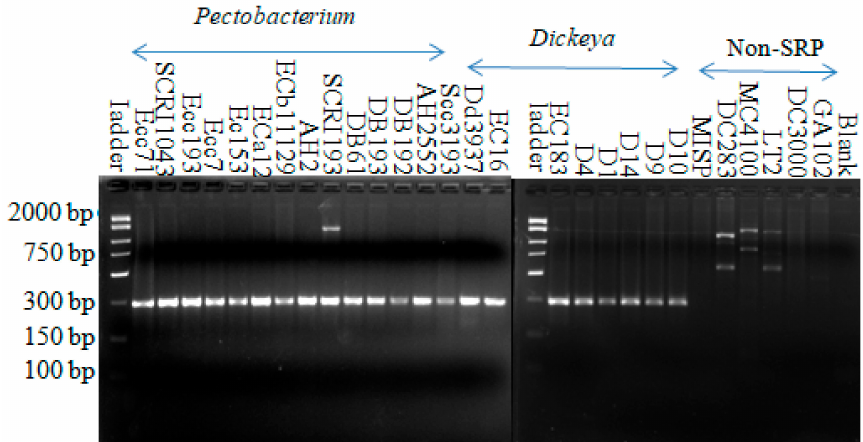
Figure 1. Amplification from all Pectobacterium and Dickeya strains with the soft rot-specific primer (SR1F-SR1R1). The names of the strains are indicated above each lane. The product size is around the expected value of 299 bp. Fifteen-microliter reactions were carried out, followed by 45 cycles of annealing at 44.9 ◦ C for 1 min and an extension of 72 ◦ C for 1 min.